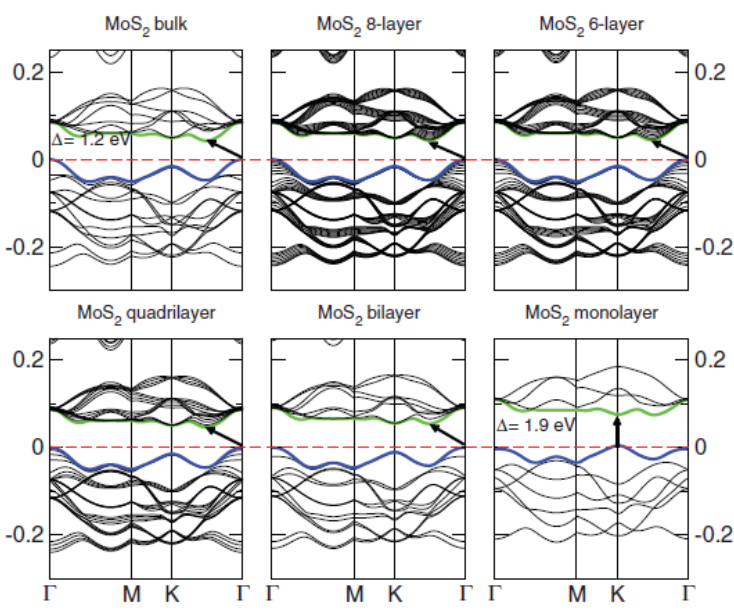
Figure 3. Band structure of different layers of MoS 2 [36]. Reprinted figure with permission from [Kuc, A.; Zibouche, N.; et al. Influence of quantum confinement on the electronic structure of the transition metal sulfide TS 2 . Phys. Rev. B 2011 , 83 , 245213] Copyright (2011) by the American Physical